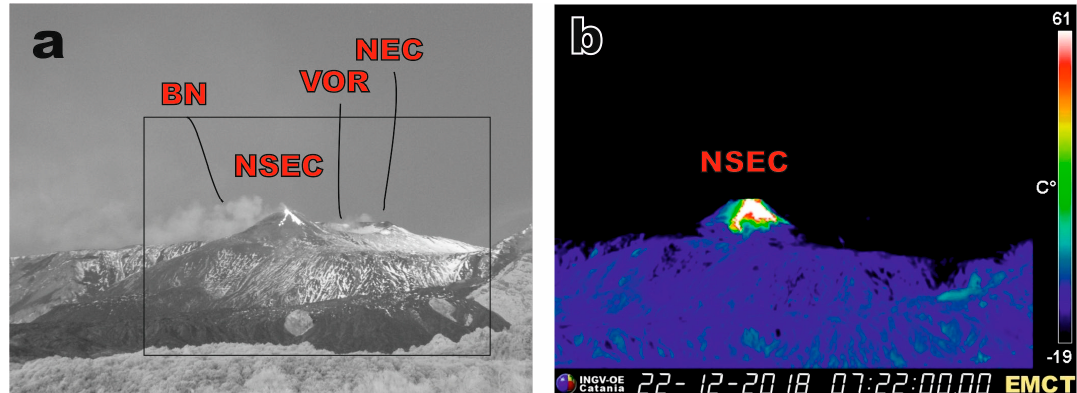
Figure 2. ( a ) Infrared image from the Monte Cagliato EMCH visual camera recorded on 22 December 2018 at 05:45 showing a view from the east of the summit craters, with the location of the NE Crater (NEC), Voragine (VOR), Bocca Nuova (BN), and New SE Crater (NSEC) erupting small lava flows from its summit (in white). The black rectangle displays the area framed in ( b ). ( b ) Thermal image recorded from the Monte Cagliato EMCT thermal camera on 22 December 2018 at 07:22 showing the active lava flows spreading on the upper eastern flank of the NSEC (in white).